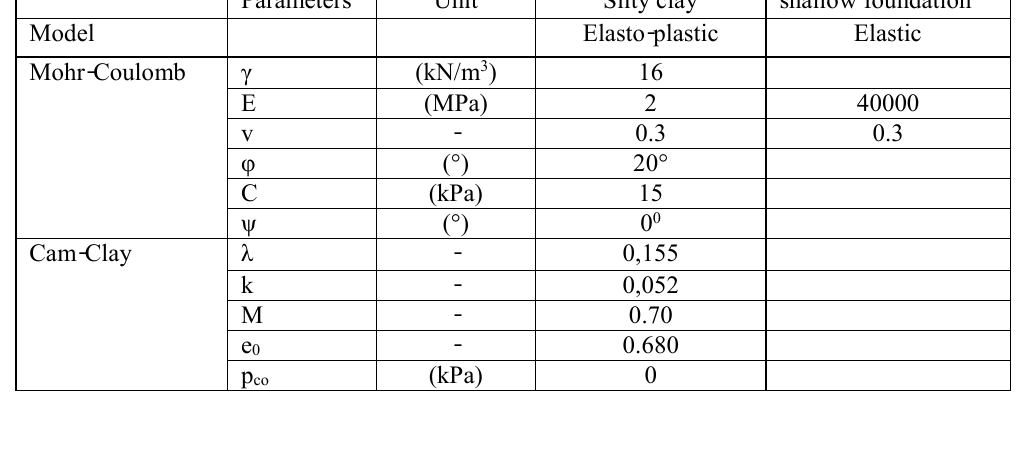
Parameters Unit Silty clay shallow foundation